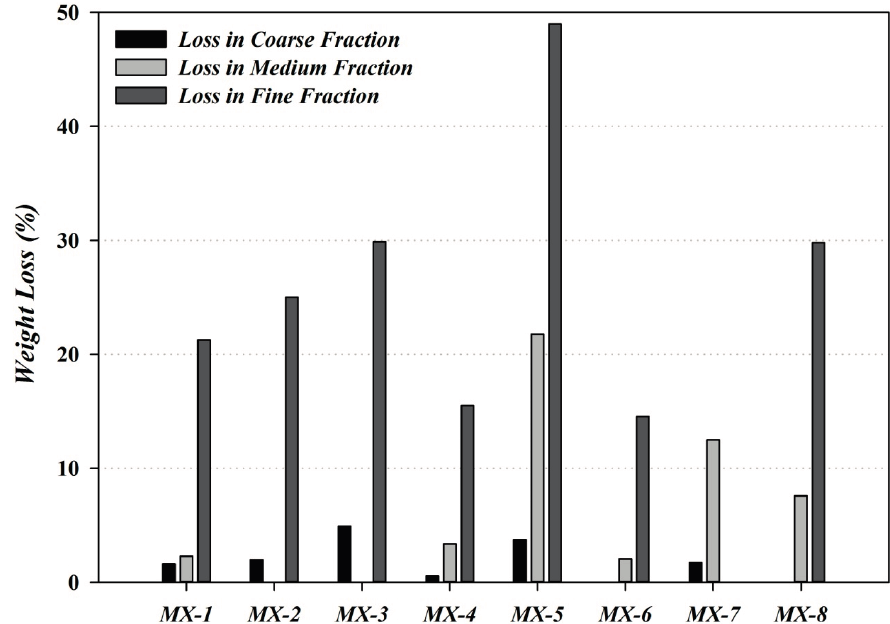
Figure 5. Weight loss (%) of coarse, medium and fine size fractions of basaltic waste-rock particles as results of tumbling process trials using different feed compositions (MX-1 to